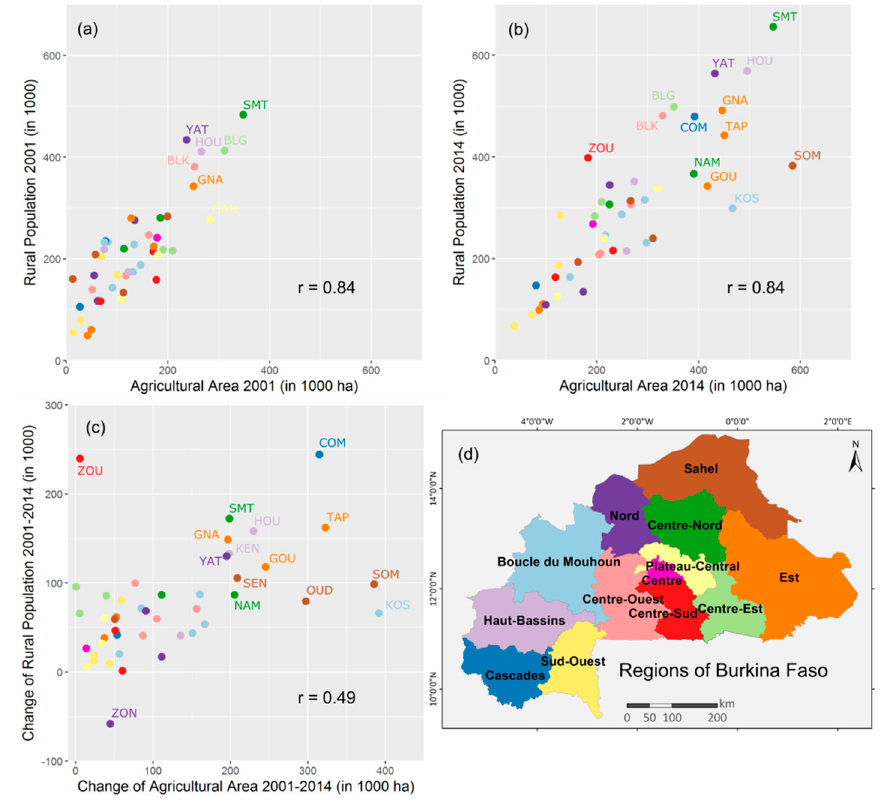
Figure 10. Scatterplots of agricultural area versus rural population in the provinces for the years 2001 ( a ) and 2014 ( b ) and the changes between the two years ( c ); the coloring of the points refers to the regions of Burkina Faso ( d ).